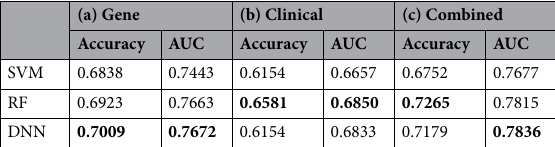
Table 1. Test performance evaluation of the final